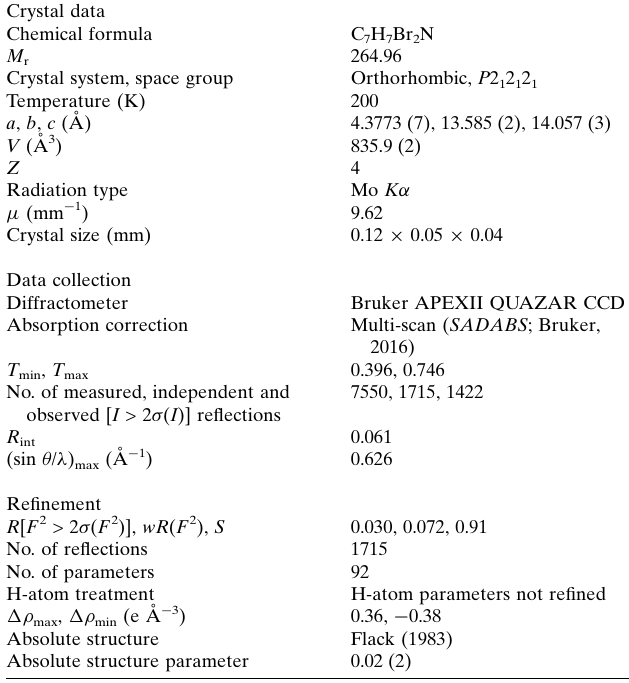
Table 2 Experimental details.